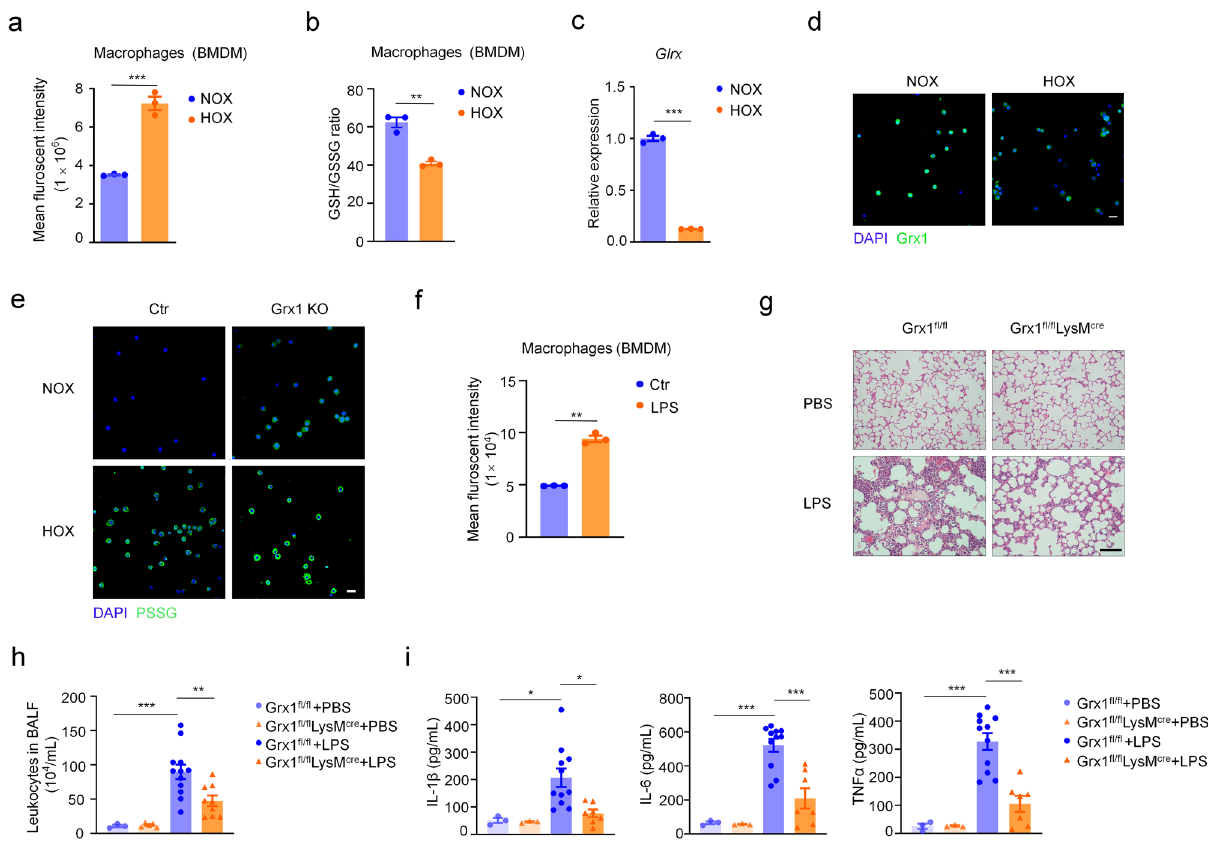
Fig. 2 Loss of Grx1 in macrophages relieves the in fl ammation of acute lung injury. a Flow cytometric analysis of intracellular ROS levels in BMDMs after culture under NOX ( n = 3) or HOX ( n = 3) for 15 min, P = 0.0004. b GSH/GSSG ratio in BMDMs after culture in NOX ( n = 3) or HOX ( n = 3) for 2 h, P = 0.0017. c Glrx mRNA expression of AMs from WT mice exposed to NOX ( n = 3) or HOX ( n = 3) as evaluated by qPCR, P < 0.0001. d Immuno fl uorescence staining of AMs from WT mice exposed to NOX or HOX (green, Grx1; blue, DAPI; scale bars, 40 μ m). e Representative confocal microscopy images of AMs from control or Grx1 KO mice exposed to NOX or HOX stained for S-glutathionylated proteins (green) using Grx1-catalyzed cysteine derivatization (nuclei are stained blue with DAPI; scale bars, 40 μ m). f Representative fl ow cytometry quanti fi cation of ROS generation in BMDMs stimulated with LPS (100 ng/mL, 5 min), n = 3 in each group, P < 0.0001. g H&E staining of mouse lung sections 24 h